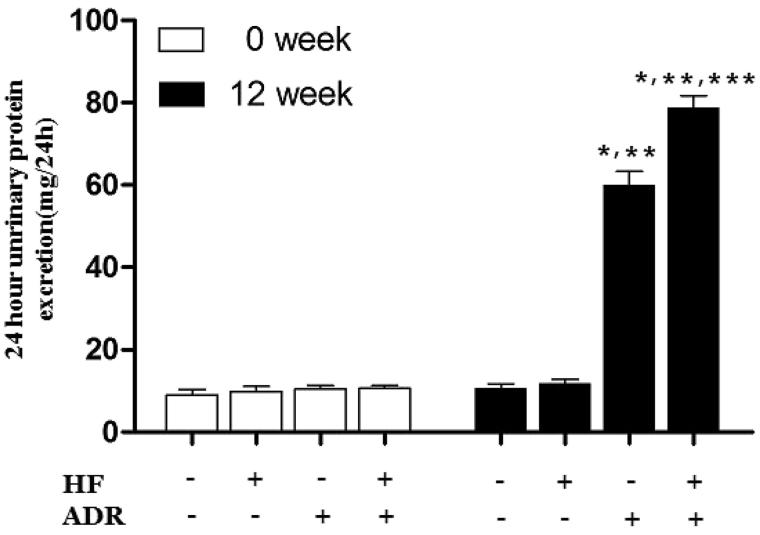
24-h urinary protein excretion for rats in each group. Data are shown as mean ± SD. Compared with Group N: *p < .05; compared with Group HF: **p < .05; compared with Group ADR: ***p < .05. n = 4.